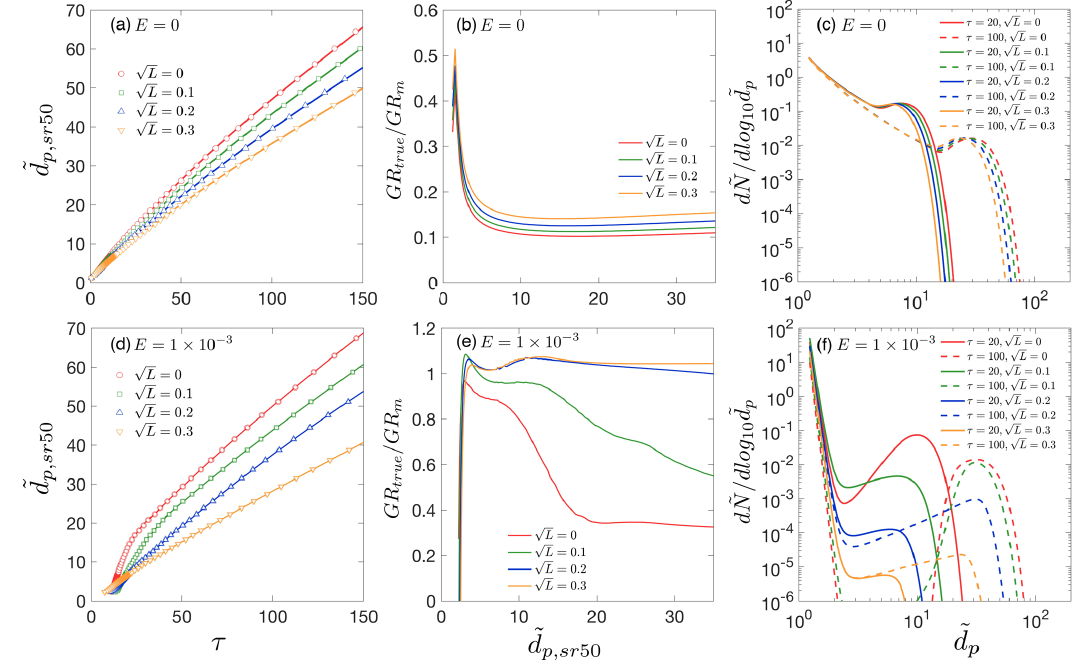
Figure 4. Effect of preexisting particles on particle growth rate. (a) e d p , sr50 as a function of time. (b) Ratio of true growth rate to measured growth rate, GR true / GR m , sr50 . (c) Particle size distributions at τ = 20 and τ = 100. Panels (a) – (c) are for collision-controlled nucleation √ L = 0, 0.1, 0.2, 0.3. Panels (d) – (f) show the same quantities as are shown in panels (a) – (c) but with E = 1 × 10 − 3 . with E = 0 and